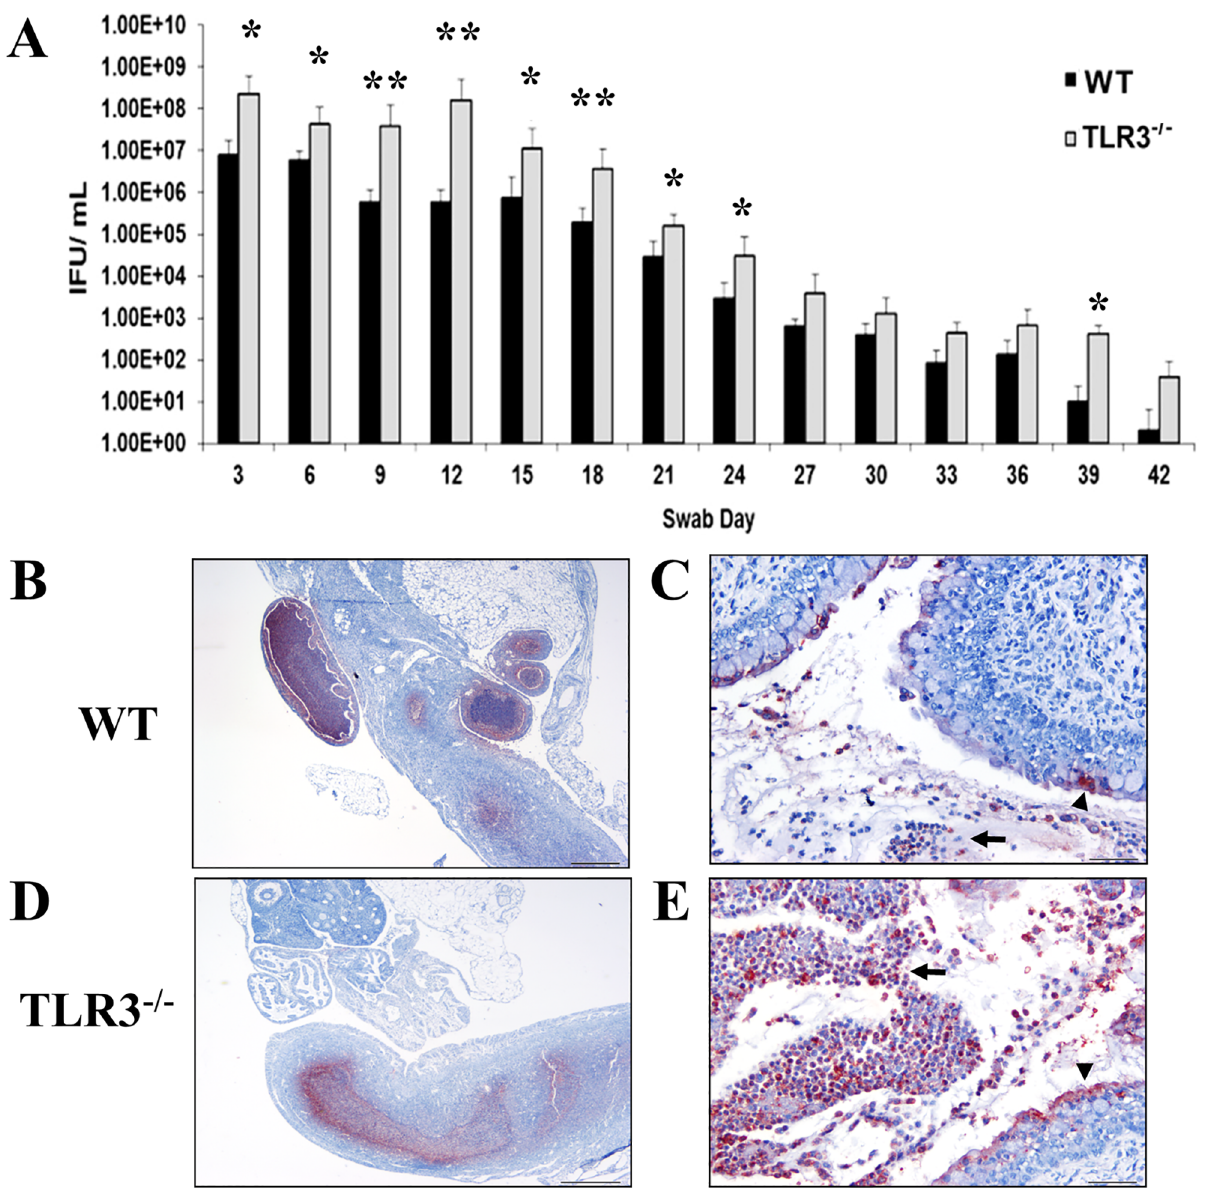
Fig 1. The levels of Chlamydia muridarum shedding from genital tracts of TLR3 -/- mice are significantly higher during the first 24 days of infection. A) Genital tract infections were performed, swabs were collected every third day for 42 days, and C . muridarum titers were determined by infecting fresh McCoy cell monolayers (see Materials and methods). Representative data from an average of 5 mice are shown. IFU = inclusion forming units. (cid:3) = p < 0.05 ; (cid:3)(cid:3) = p < 0.005 . B-E) Immunostaining of Chlamydia muridarum in genital tracts to wild-type (WT) and TLR3 -/- mice at day 7 post- challenge. Detection of Chlamydia antigen (red staining) within neutrophils (arrow) and epithelial cells (arrowhead) in oviducts (B), endometrium (C), and cervix from a representative WT mouse. Detection of Chlamydia antigen (red staining) associated with neutrophils (arrows) and epithelial cells (arrowhead) in endometrium and cervix (D and E), from a representative TLR3 -/- mouse. https://doi.org/10.1371/journal.pone.0195165.g001 The inflammatory cell infiltrate in the genital tract of wild-type and TLR3 -/- mice at middle stages (day 21 of infection) of C . muridarum infection was predominantly composed of lym- phocytes when compared with mock-inoculated controls. As shown in Fig 3, the degree of lymphocytic inflammation in the genital tract of TLR3 -/- mice was significantly different to the inflammation noted in the genital tract of wild-type mice. Scattered throughout the